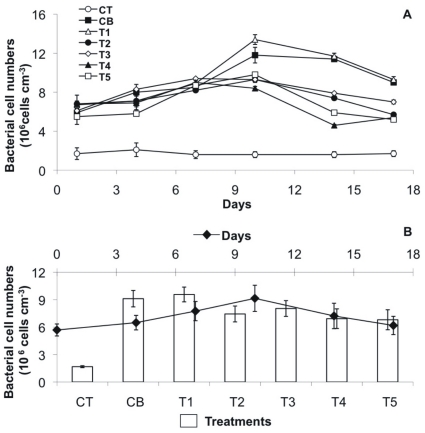
Bacterial cell numbers over the course of the experiment.(A) Mean values (n = 4 per treatment) with SE of the different treatments over time: positive control CB (black squares), negative control CT (white circles), T1 (TCS: 2 µg/L, white triangles), T2 (TCS: 10 µg/L, black circles), T3 (TCS: 20 µg/L, white diamonds), T4 (TCS: 50 µg/L, black triangle), T5 (TCS: 100 µg/L, white squares). (B) Mean values with SE per day (n = 7, black diamonds) and per treatment (n = 6, bar plots).